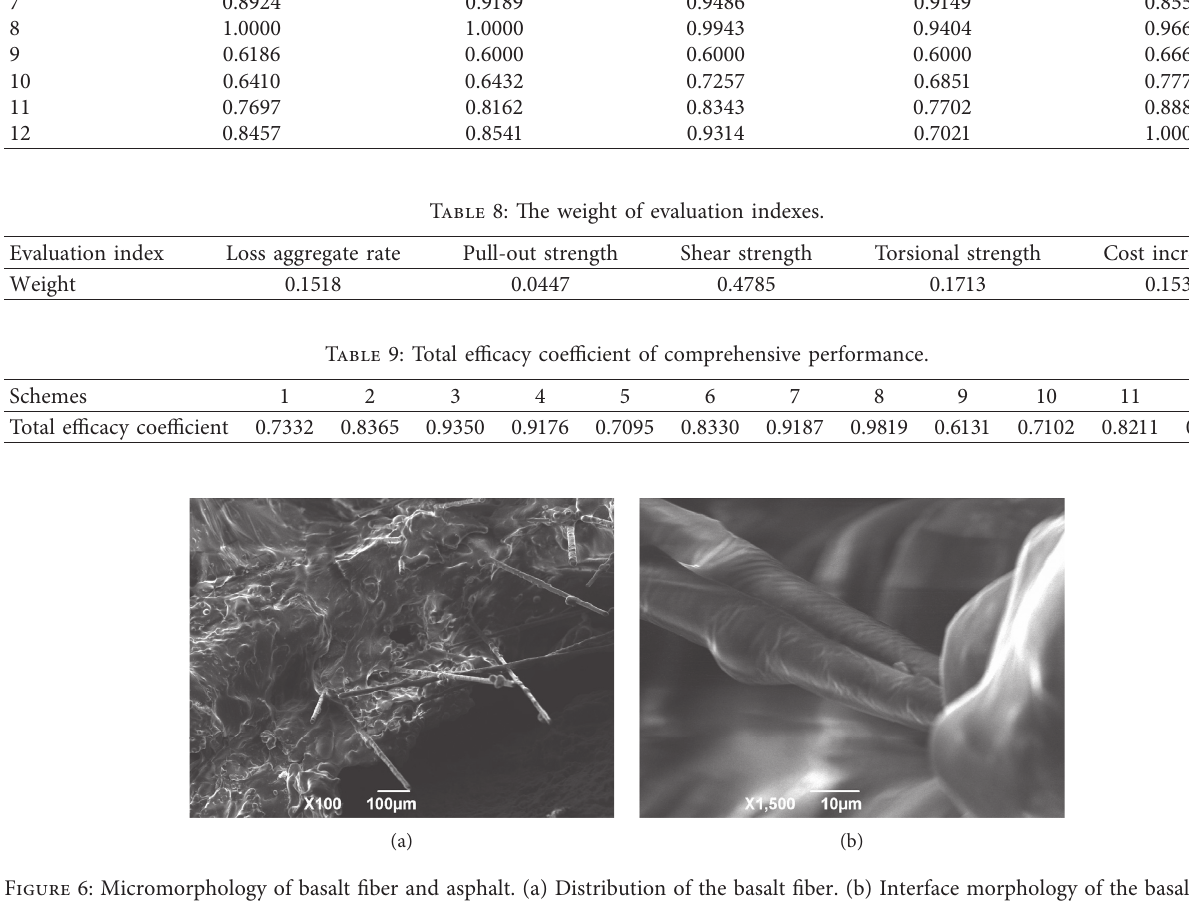
Figure 6: Micromorphology of basalt fiber and asphalt. (a) Distribution of the basalt fiber. (b) Interface morphology of the basalt fiber.